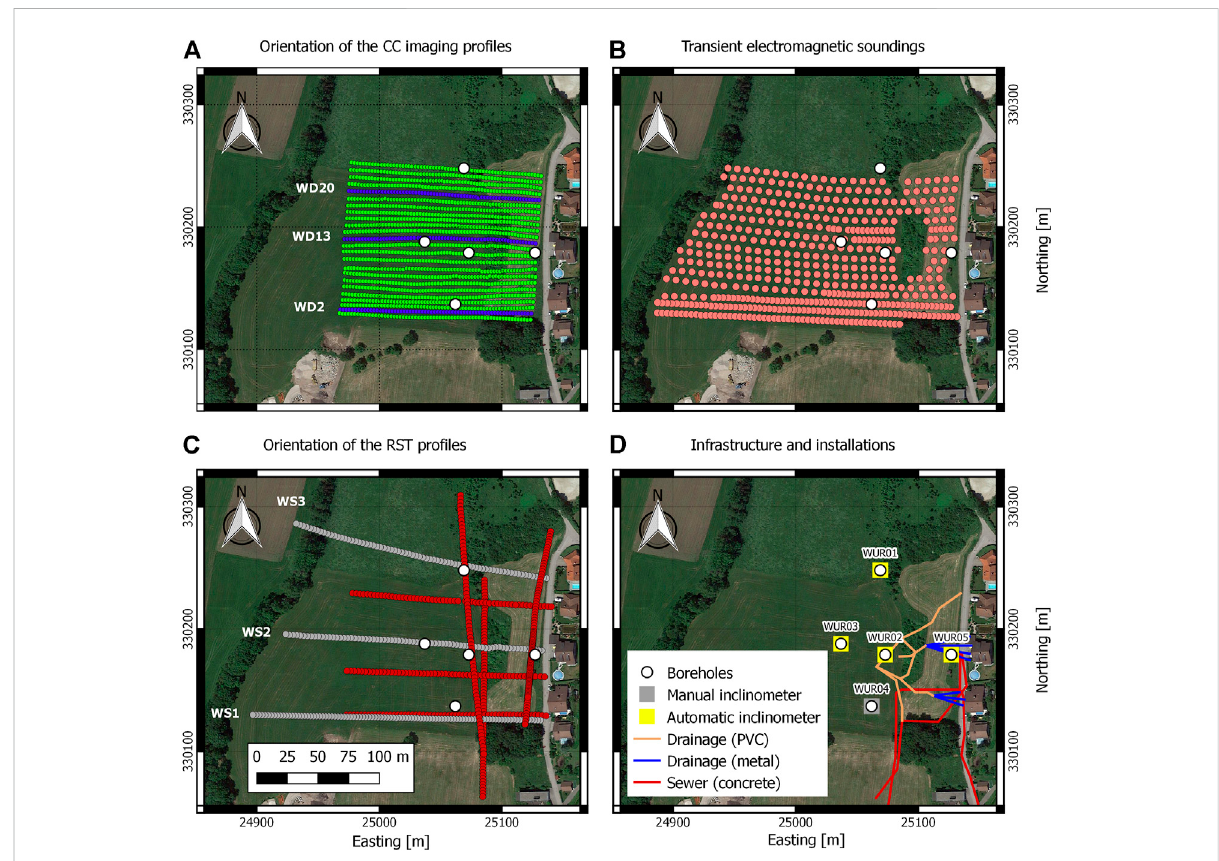
FIGURE 2 Overview of geophysical and geotechnical surveys as well as known infrastructure. The colored dots in (A – C) represent the location of the (A) electrodes and (C) geophones in each pro fi le as well as the location of the (B) individual TEM soundings.